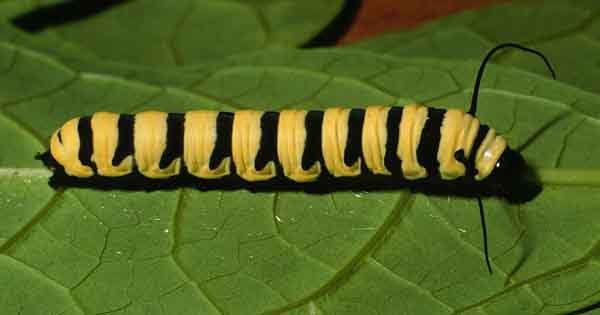
Lycorea
h.
atergatis voucher n. 99-SRNP-5616, feeding on Caricaceae. Image voucher n. DHJ51243.jpg